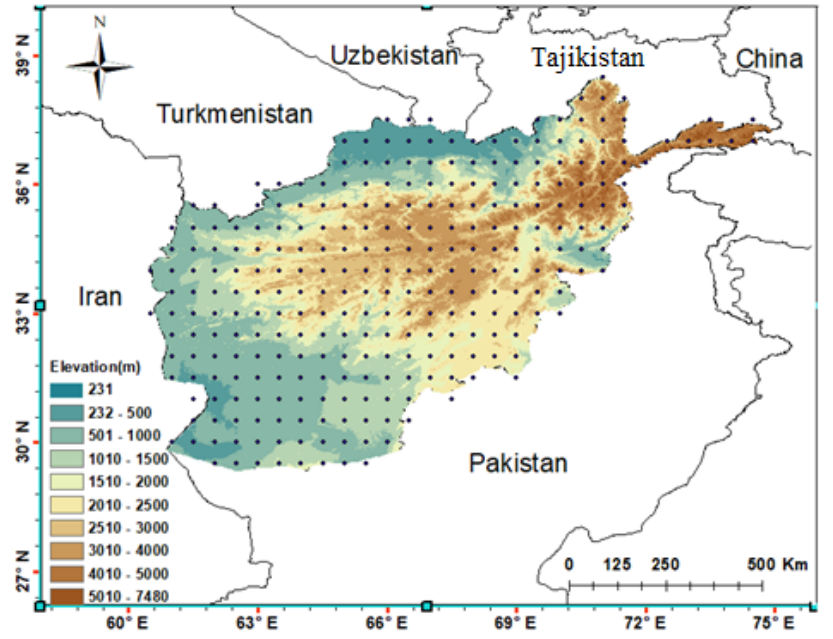
Figure 1. Map of Afghanistan showing elevation and country borders.